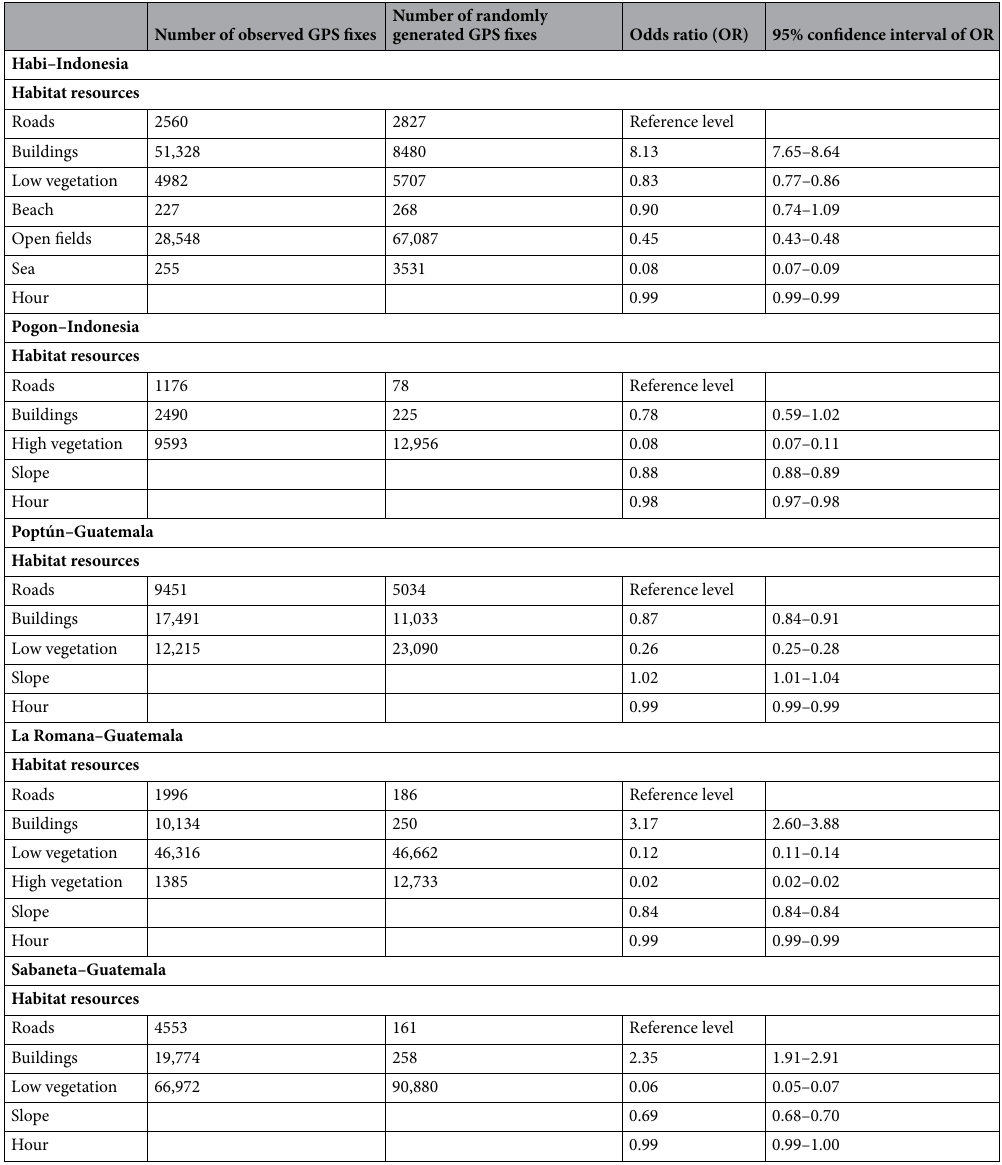
Table 2. Results (odds ratio and 95% confidence interval for the explanatory variables habitat, time and slope) of the spatial mixed effects logistic regression model with “roads” as the resource reference level of 321 free-roaming domestic dogs in Indonesia and Guatemala. This table details the total number of observed and randomly generated GPS fixes present in each study site resource. Note: Confidence intervals that do not include 1 correspond to a p -value of < 0.05 and thus present a significant effect on the α =